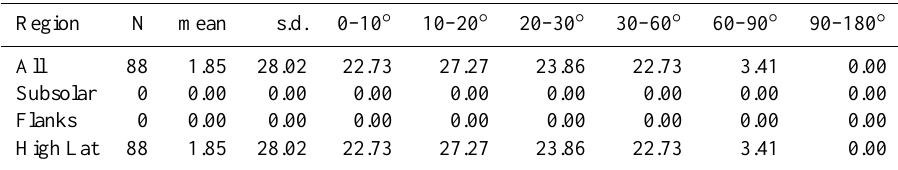
Table 13. Distribution of angular differences in the low pressure case (solar wind dynamic pressure ≤ 2nPa) for Southward IMF (IMF clock angle between − 165 ◦ and 165 ◦ ). Format as in Table 3